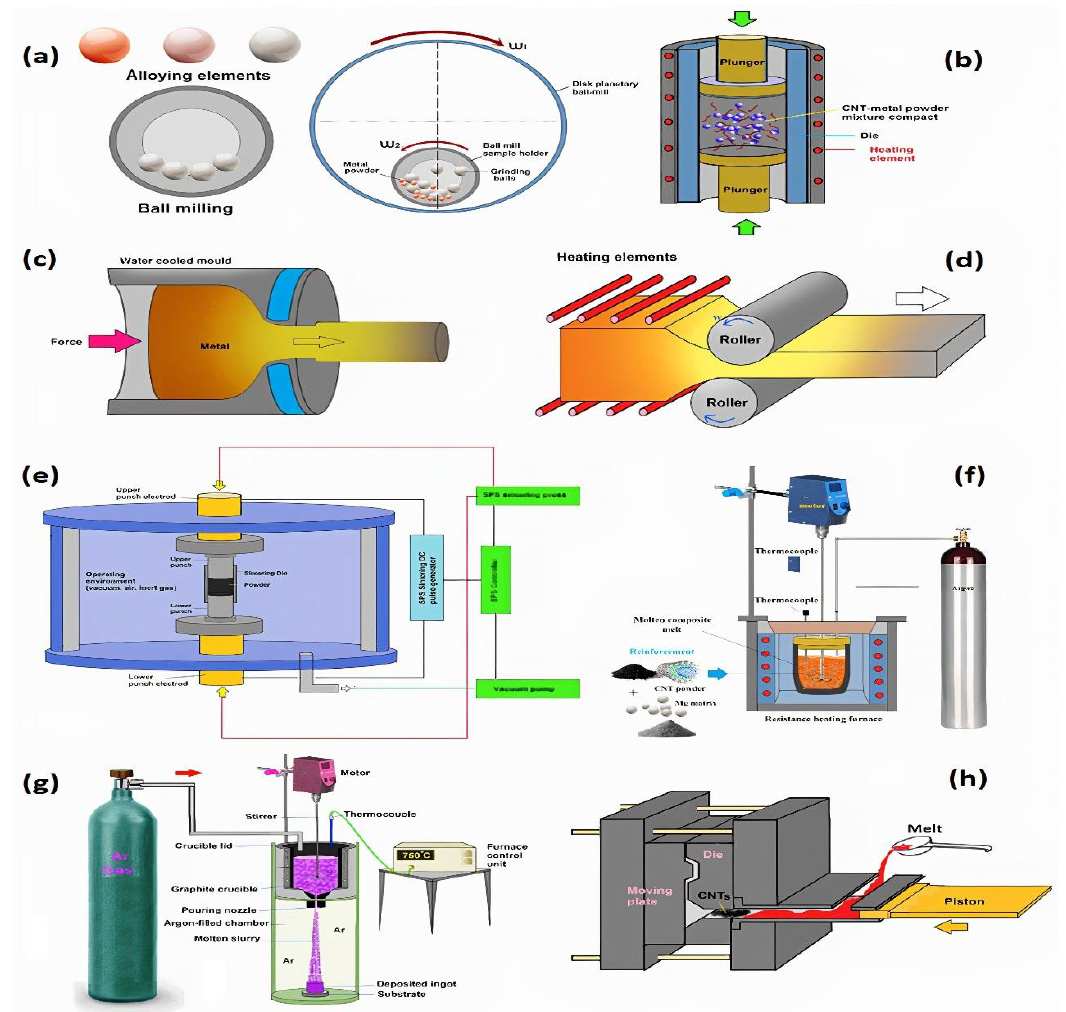
Figure 3. Various fabrication methods associated with powder metallurgical route: ( a ) powder metallurgy-ball milling [15,50], ( b ) direct current sintering [50], ( c ) extrusion based on hot working [50], ( d ) rolling based on hot working [50], ( e ) pulsed electric current sintering (PECS) [50], ( f ) stirring based casting (SC) [50], ( g ) deposition of disintegrated melt (DDM) [11,50], and ( h ) die casting featured with high pressure